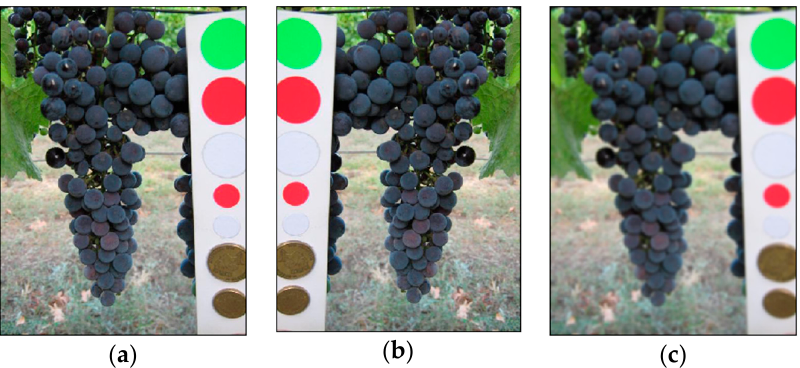
Figure 6. Examples of train dataset augmentation: ( a ) original image; ( b ) horizontal flipping; ( c ) image blurring.